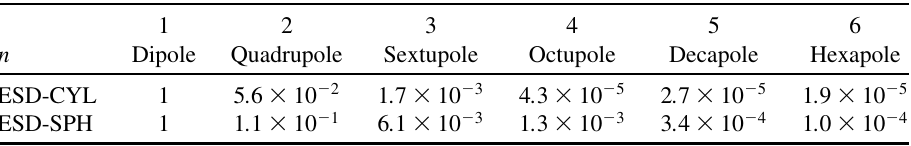
TABLE I. Integral electric field harmonics of cylindrical and spherical deflectors. Data are normalized to the main dipole component n ¼ 1